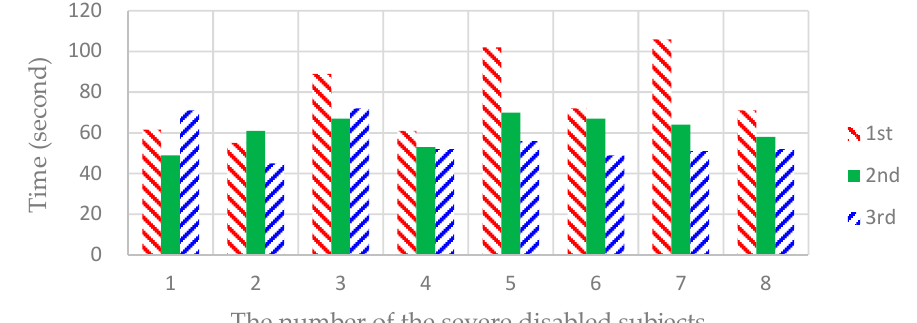
Figure 9. The test data of the mouse mode of MCT for 8 severely disabled subjects (3 times per subject).